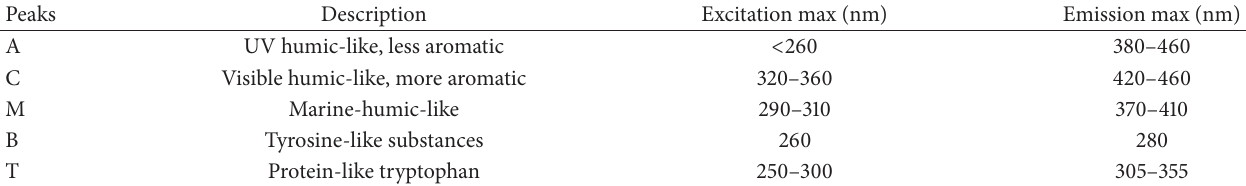
Table 4: Peaks, description, and excitation/emission maxima of fluorescent DOM.